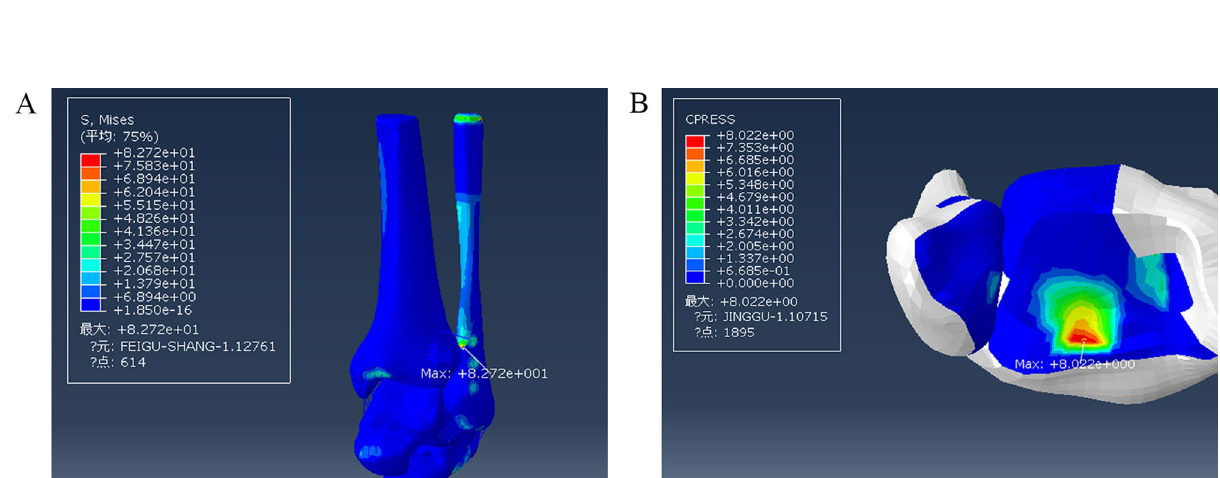
Figure 10. Stress distribution during external ankle fracture associated with injury to the posterior tibiofibular ligament in a stage III supination-external rotation ankle injury. ( A ) Maximum stress view. ( B ) Maximum contact stress view. Units of measurement: